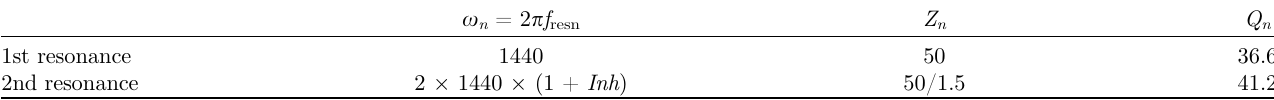
Table 1. Values of the modal parameters of the two resonance ’ s air column.